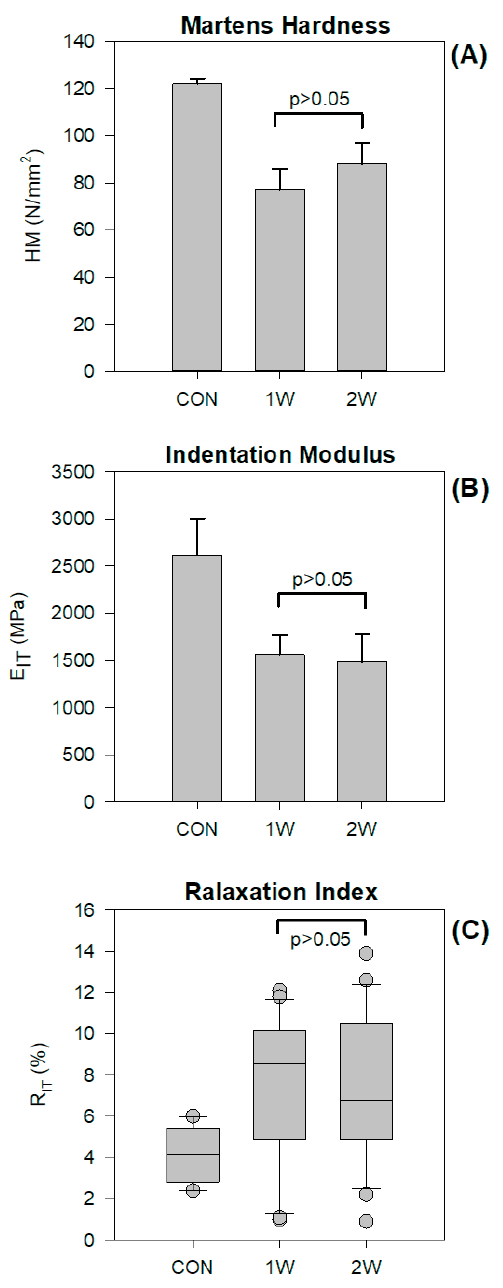
Figure 4. Mean values and standard deviations of the Martens hardness ( A ) and indentation modulus ( B ) of groups tested. Medians, 25% and 75% percentiles, and outliers (demonstrated as circular points) for the relaxation index ( C ). Horizontal lines connect the mean values without statistically significant differences.